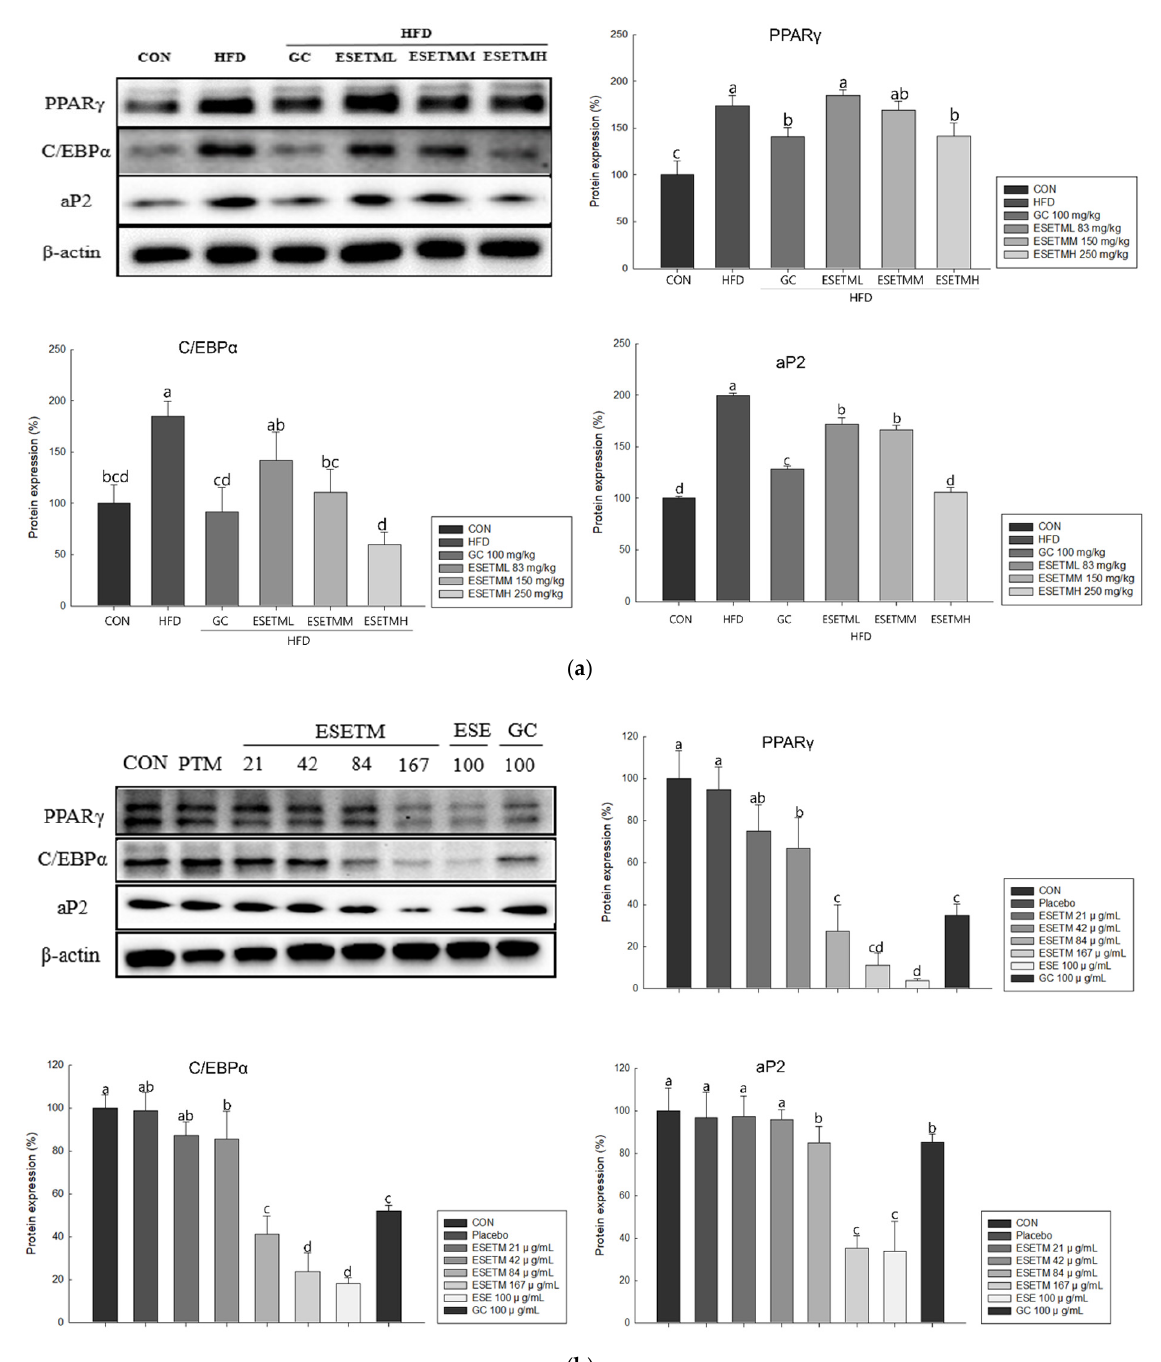
Figure 4. Effects of ESETM on adipogenic protein expression in ICR mice fed HFD after 7 weeks and adipocytes treated with ESETM. ( a ) Western blots of adipogenic proteins in WAT. ( b ) Western blots of adipogenic proteins in 3T3-L1 adipocytes. Data are shown as the means ± standard deviation (SD) ( n = 5). Different lower case letters above columns indicate statistical differences at p < 0.05.